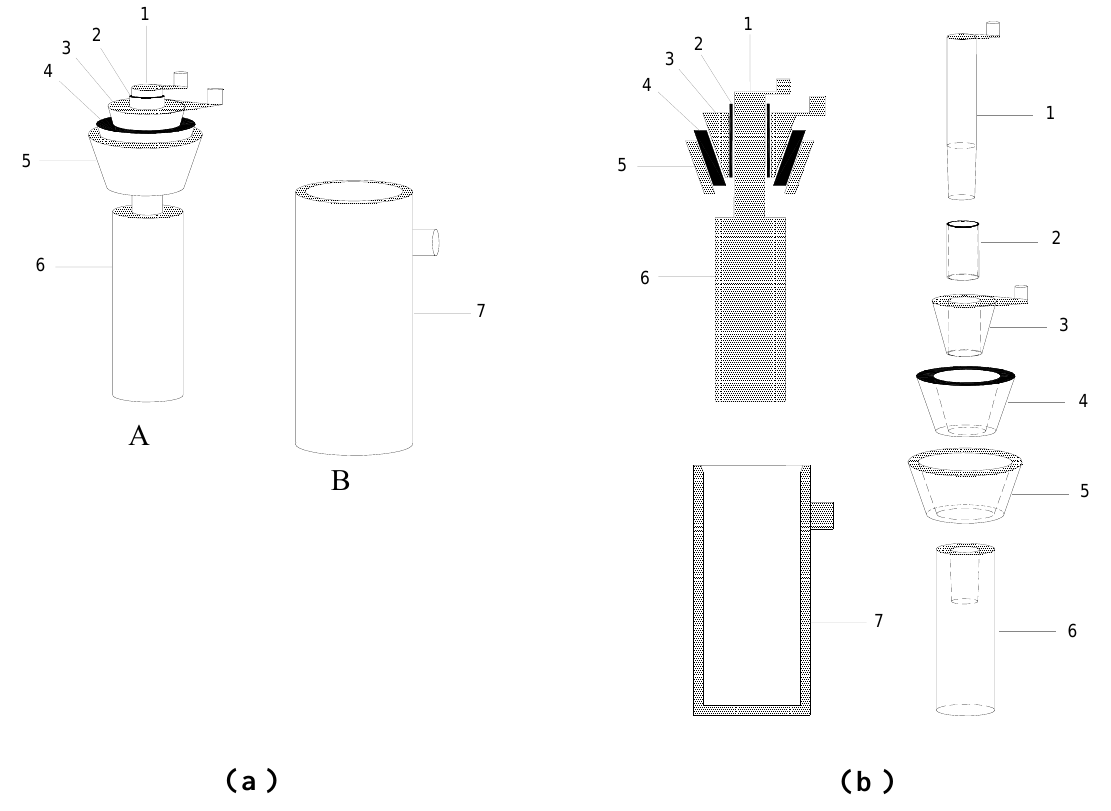
Figure 3. Liquid test fixture proposed for measuring the complex permittivitiy of highly insulating petrochemical products. (a) The overall view of the inner coaxial electrode A and the outer electrode B. (b) The cross-section of the two electrodes and the various parts of the inner electrode assembly. 1: Part 1 of electrode A, 2: PTFE insulator, 3: Guard ring, 4: XLPE conical insulator, 5: Conical